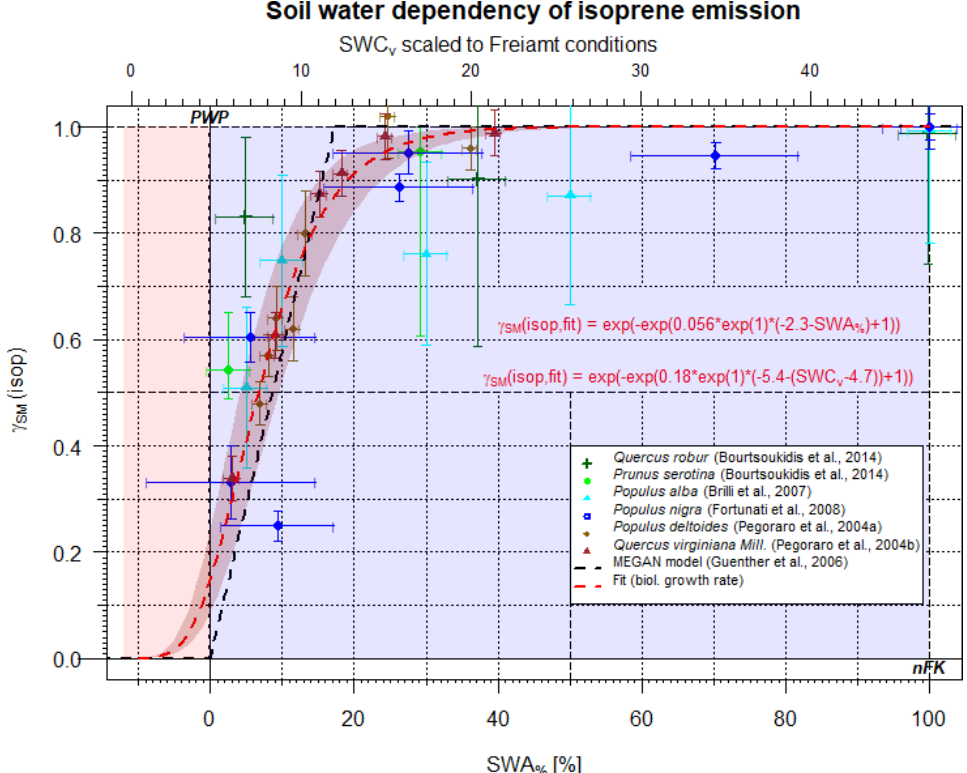
Figure 1. Scaling parameter γ SM (isop) for the effect of soil moisture on isoprene emissions as a function of SWA % (lower x axis) and, for comparison, the SWC v for a selected condition (upper x axis). Data points represent observations, and different colors refer to different studies. The dashed black line displays the approach by Guenther et al. (2006, 2012). The red line displays the present